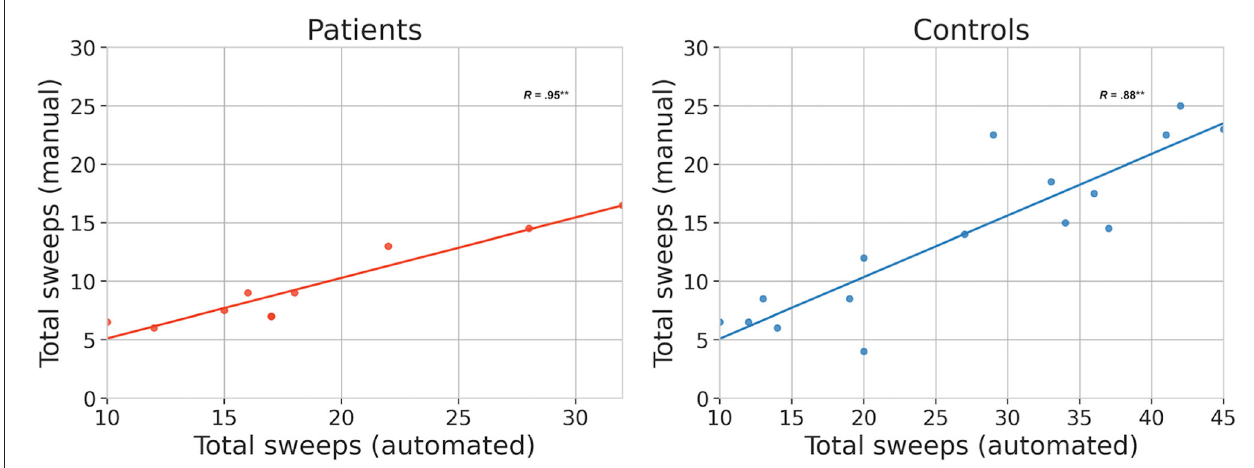
FIGURE 2 | Validation results. Relationship between manual and automated (TT) methods for quantifying bulbar function based on the same video clips. The total number of sweeps are plotted separately for patients ( N = 10) and healthy controls ( N = 16). Correlations marked ** are significant at the 5% level.